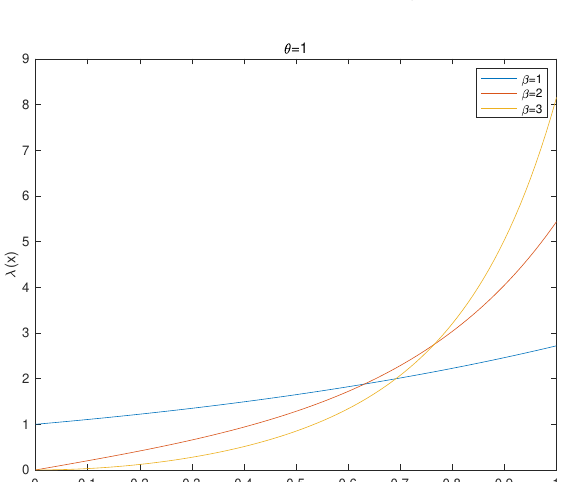
Figure 5. λ ( x ) when θ = 7, 0 < β < 1.